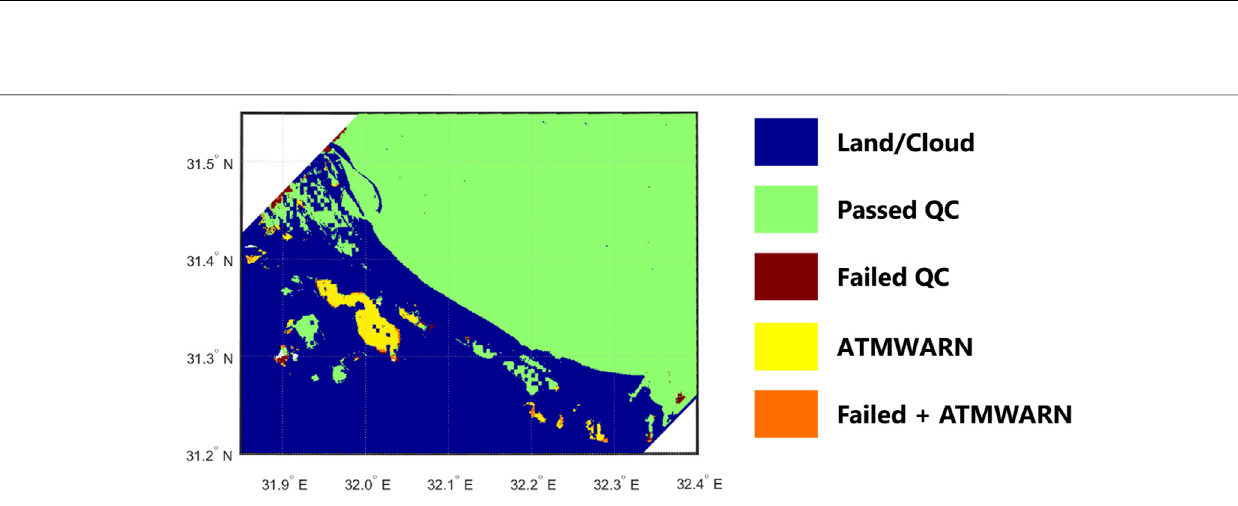
FIGURE 10 | A binary quality control (QC) map of a HICO satellite image, illustrating locations in which the NASA processing “ l2gen ” fl ags identi fi ed pixels with suspect quality (ATMWARN) and pixels identi fi ed as either passing (|QWIP| < 0.2) or failing (|QWIP| > 0.2) QC with the QWIP method. Orange pixels were fl agged by both QWIP and